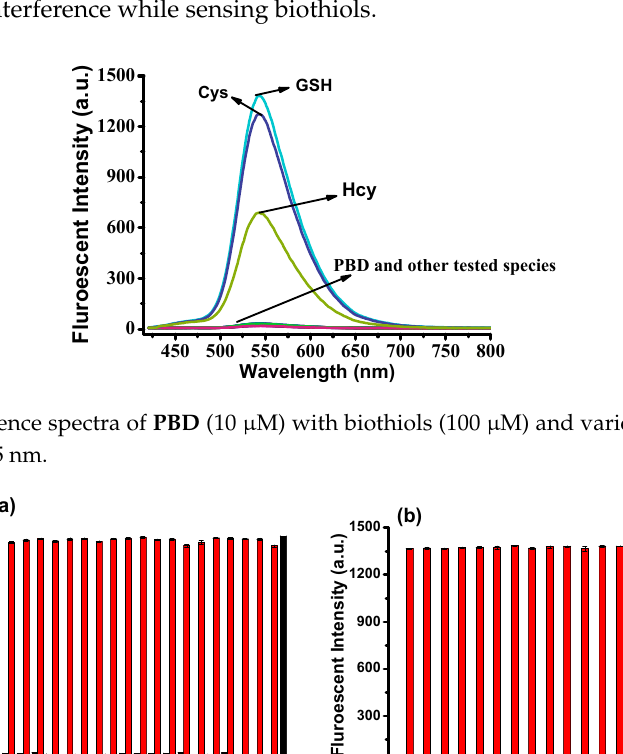
Figure 5. Partial 1 H-NMR spectra of PBD before the addition ( a ) and the change after addition of Cys, 2 min ( b ), 5 min ( c ), and 20 min ( d ), and of PBOH ( e ) in DMSO- d 6 /D 2 O (8/2, v/v ). To confirm the sensing mechanism, we also carried out 1 H-NMR titration experiments to track product formation. After the addition of excessive Cys to PBD in DMSO -d 6 /D 2 O (8/2, v/v ), the signals of PBD (H a and H b ) gradually declined. At the same time, three peaks corresponding to the protons (H a ’, H b ’, and H c ’) attributable to PBOH began to appear, indicating that PBOH had been released. With the continuation of this chemical reaction, the signals of PBOH (H a ’, H b ’, and H c ’) gradually increased. The signals of PBD (H a and H b ) had almost completely disappeared at 20 min. These results demonstrate the cleavage of the DNBS group and the production of fluorophore PBOH (Figure 5). Figure 6. Frontier orbital diagrams of PBOH and 2,4-dinitrophenylsulfonyl (DNBS). Orbital energies were calculated using Gaussian 03 program at B3LYP/6-31 g (d, p) level.